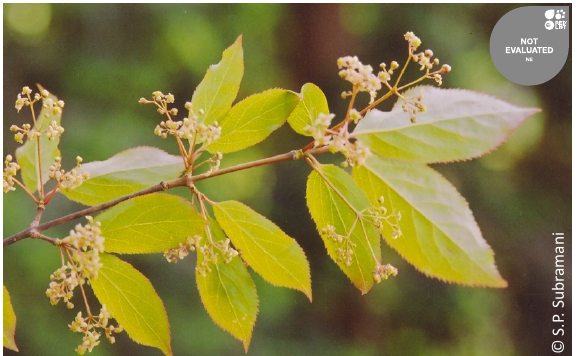
Image 42. Euonymus hamiltonianus Wall.